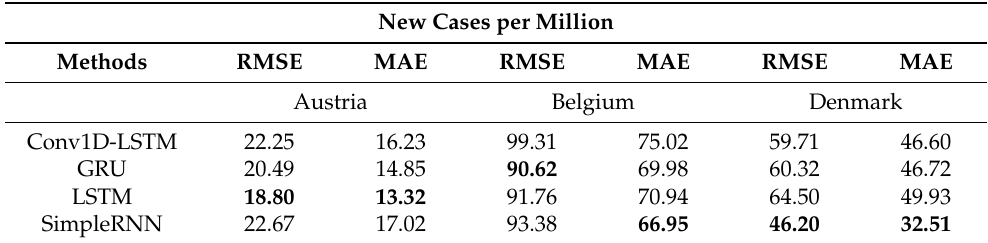
Table 3. Errors for New Cases per Million for each country per method. Bold values showcase the minimum error achieved in each